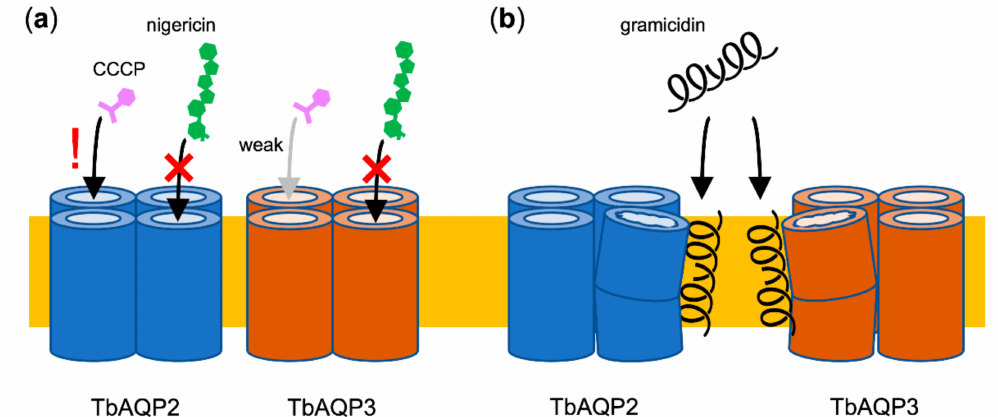
Figure 6. Proposed mechanisms of direct inhibition of TbAQPs by ionophores. ( a ) The small, mobile ionophore CCCP is compatible with high-a ffi nity binding to the TbAQP2 interior but only weakly with that of TbAQP3 probably due to the di ff erences in the selectivity filter layout. The larger nigericin does not bind to any TbAQP. ( b ) The membrane-integral, pore-forming gramicidin disturbs the fold and functionality of TbAQP2 and TbAQP3 by more unspecific